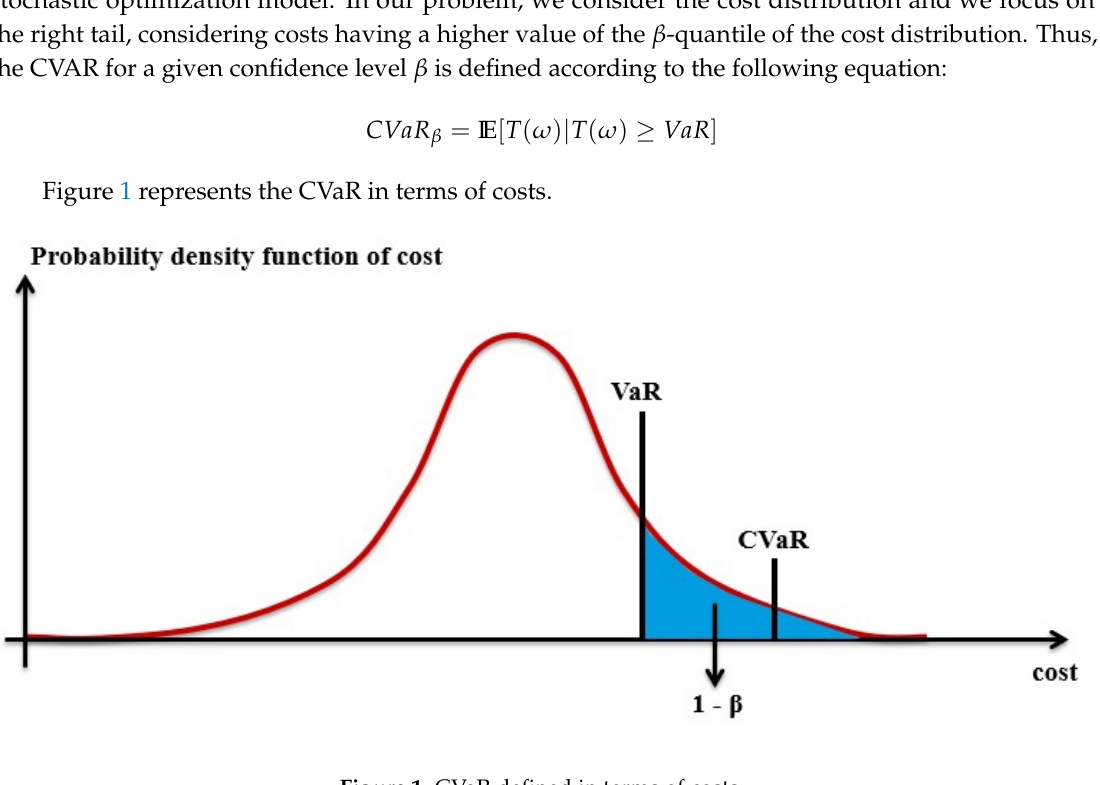
Figure 1. CVaR defined in terms of